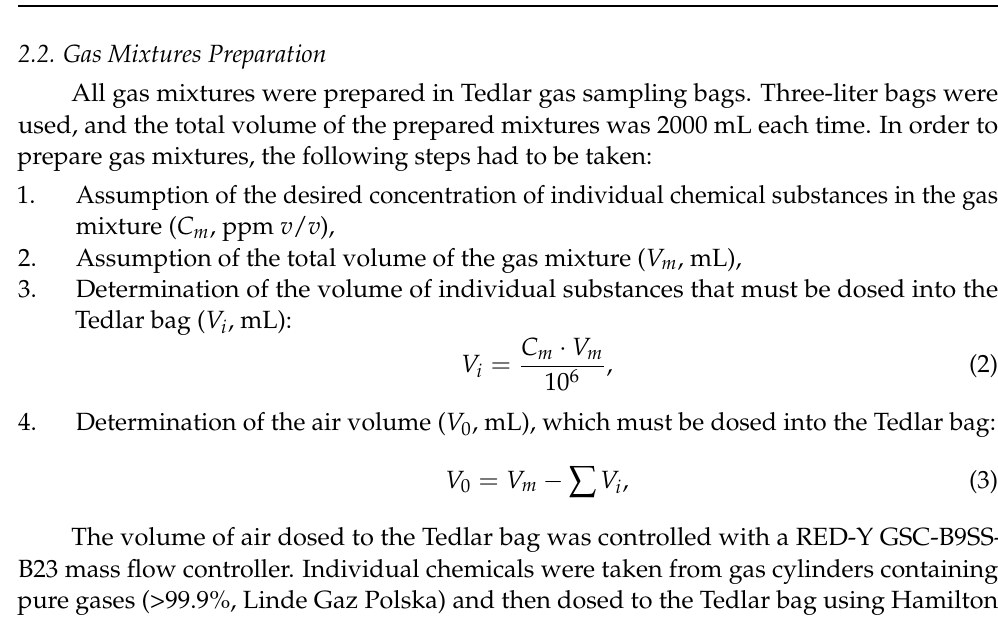
(3) air filter, (4) gas sensor array, (5) temperature sensor, (6) humidity sensor, (7)